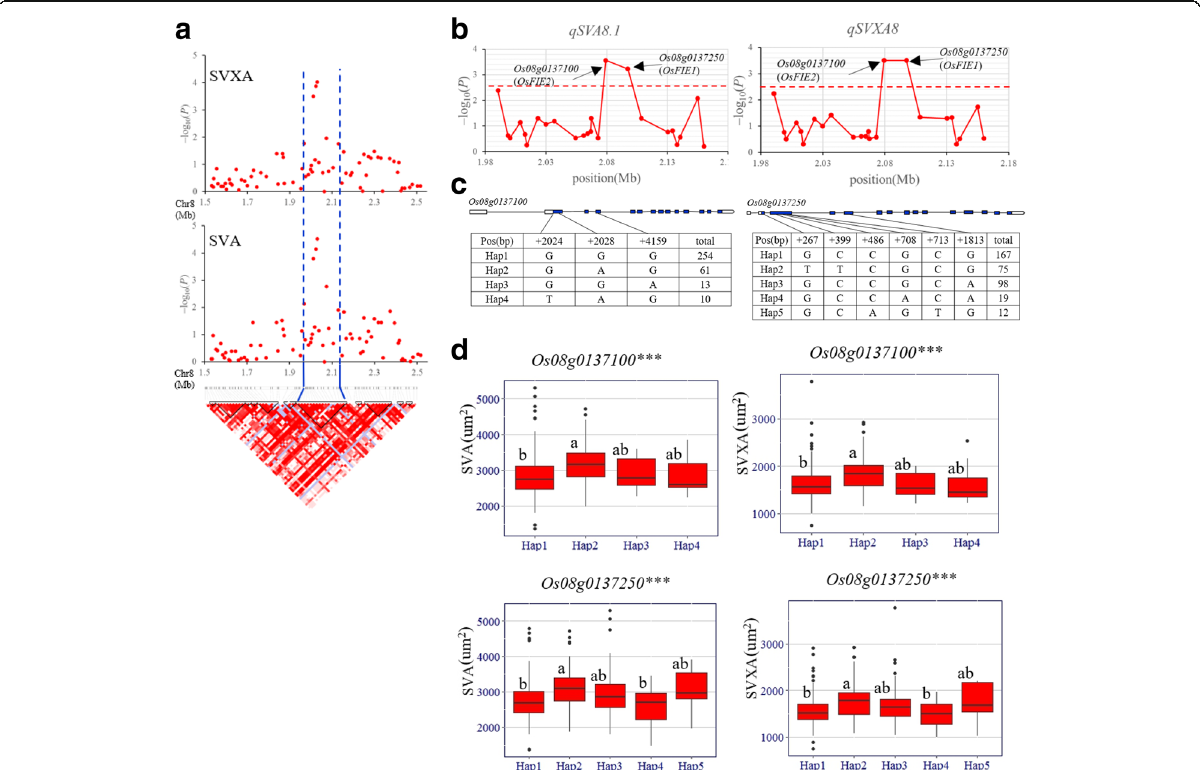
Fig. 6 Gene-based association analysis and haplotype analysis of targeted genes related to qSVA8.1 and qSVXA8 . a Local Manhattan plot (top) and LD block (bottom) surrounding the peak on chromosome 8. Dashed lines indicate the candidate region for the peak. b Gene-based association analysis of targeted genes related to qSVA8.1 and qSVXA8 . Each point is a gene indicated by one SNP having largest – log10 ( P ) value. Dash line show the threshold to determine significant SNP. c Exon-intron structure of Os08g0137250 and Os08g0137100, and DNA polymorphism in those gene. d Boxplots for SVA and SVXA based on the haplotypes (Hap) for Os08g0137250 and Os08g0137100 . The *** suggest significance of ANOVA at P < 0.001. The letter on histogram (a, and b) indicate multiple comparisons result at the significant level 0.05. Green and red colors indicate in 2015 and 2016,